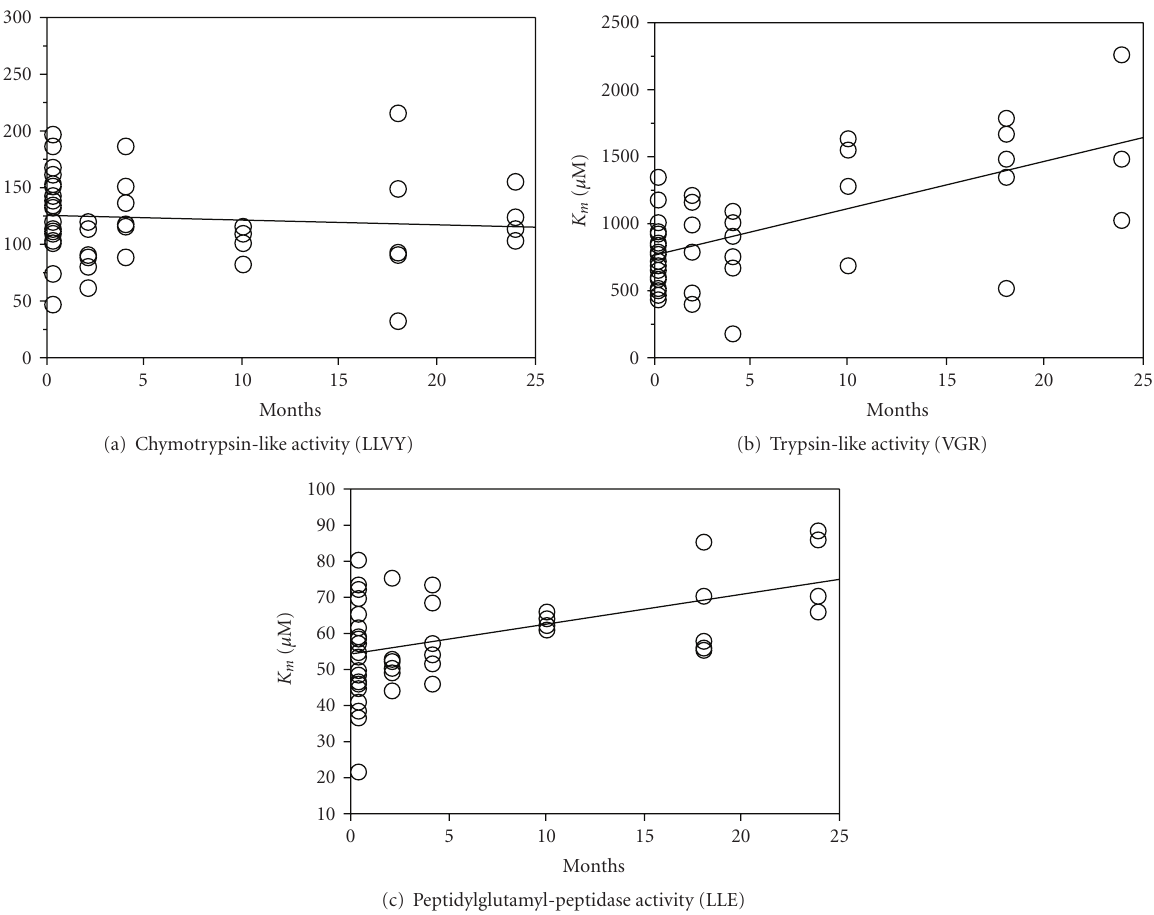
Figure 3: Michaelis-Menten constants ( K m ) of the proteasome in rat lens with age: E ff ect of aging on Michaelis-Menten constants of the proteasome in rat lens. K m -values were calculated as previously described (Materials and Methods, legend Figure 1). (a) Chymotrypsin-like activity: R 2 = 0 . 008, P = . 535 . (b) Trypsin-like activity: R 2 = 0 . 433, P < . 0001 . (c) Peptidylglutamyl peptidase activity: R 2 = 0 . 242, P = . 0004 . A P -value of less than .05 was considered statistically